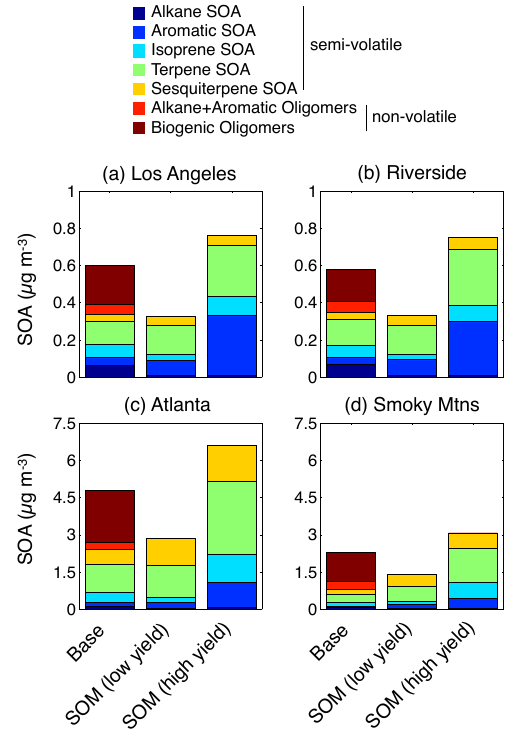
Figure 4: 2-week averaged SOA concentrations at Los Angeles (a), Riverside (b), Atlanta (c) and Smoky Figure 4. The 2-week averaged SOA concentrations at (a) Los An- Mountains (d) for the Base and SOM simulations resolved by the SOA precursor. geles, (b) Riverside, (c) Atlanta and (d) Smoky Mountains for the Base and SOM simulations resolved by the SOA